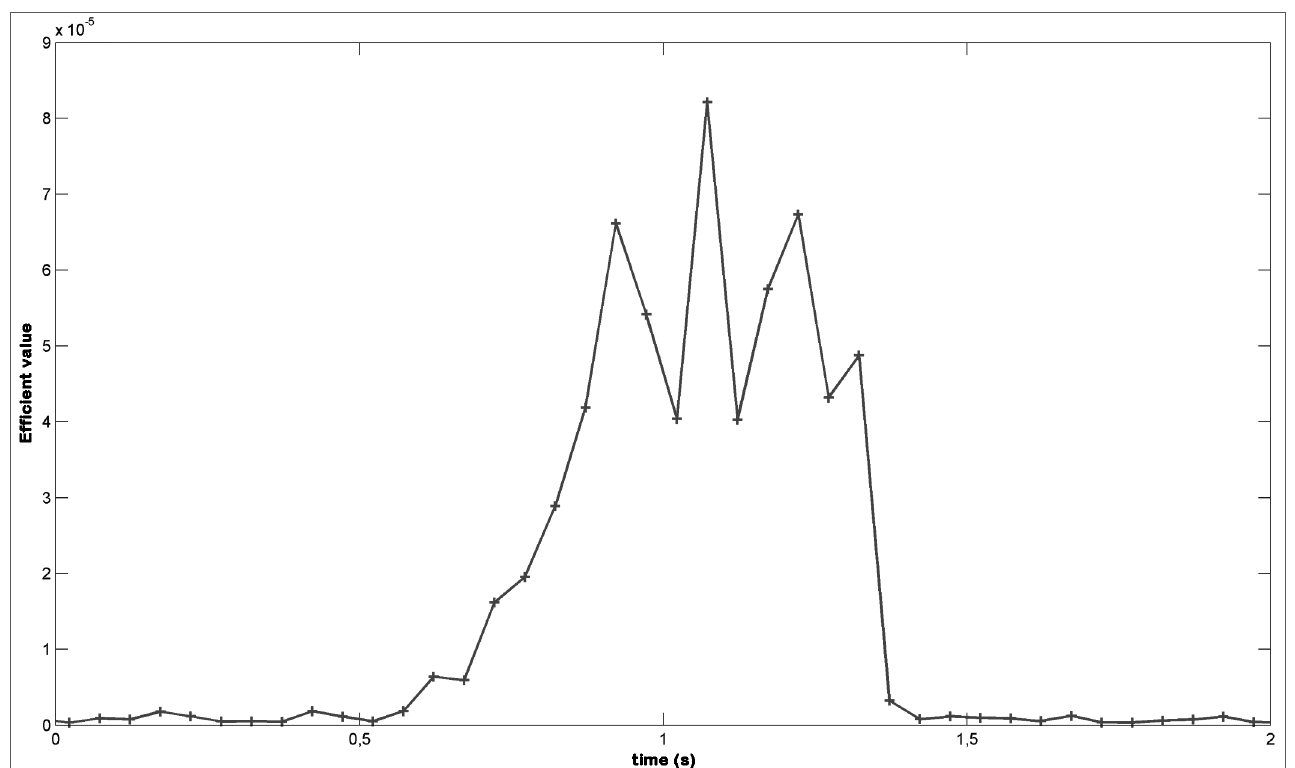
Figure 3. Effective value of the snoring signal - Example of calculating the effective value of the snoring